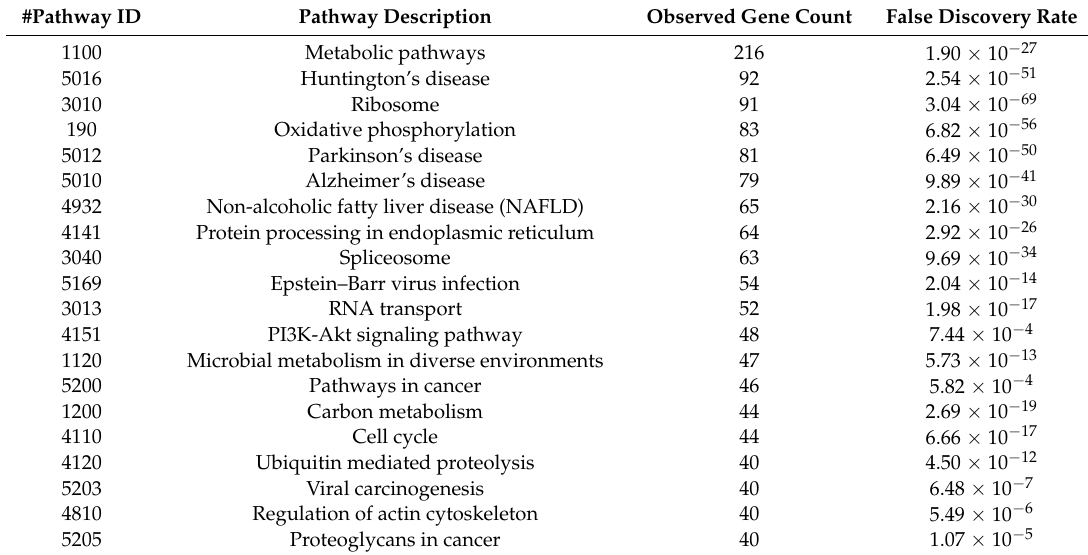
Figure 3. Validation of transcriptome in SHH MB CSC versus NSC. mRNA expression levels of Ccnd1 , Hdac2 , Cdkn1a , Atf4 , Bcat1 , Ccnd2 , Egfr , Myc , and Hif1a in SHH MB CSCs compared to NSCs. Results are shown in relative expression and data are means ± SD from three independent experiments. p -values * p < 0.05; ** p < 0.01. Table 3. Top 20 KEGG (Kyoto Encyclopedia of Genes and Genomes) pathways from enrichment analysis of SHH MB CSC transcriptome. The entire table is reported in Table S4.